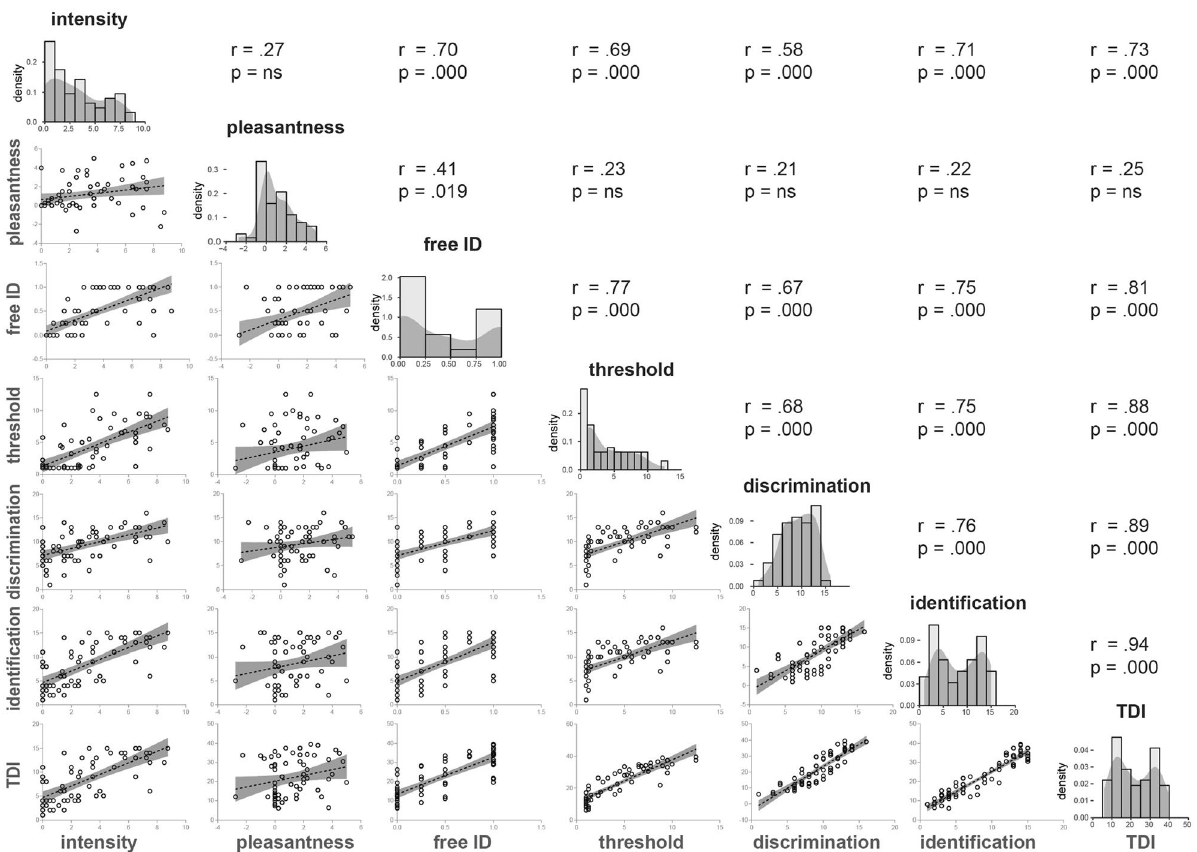
Figure 4. Cross-correlations between olfactory function measures and distribution of scores regardless of group. Diagonal shows histograms and density plots of distribution of scores. Below the diagonal scatterplots illustrate the relation between variables indicated at the bottom of each column and the left of each row. Lines illustrate best fit of linear regression, with the transparent gray area indicating 95% confidence bands. Above the diagonal the Pearson correlation and p value of significant statistic are given. Ns not